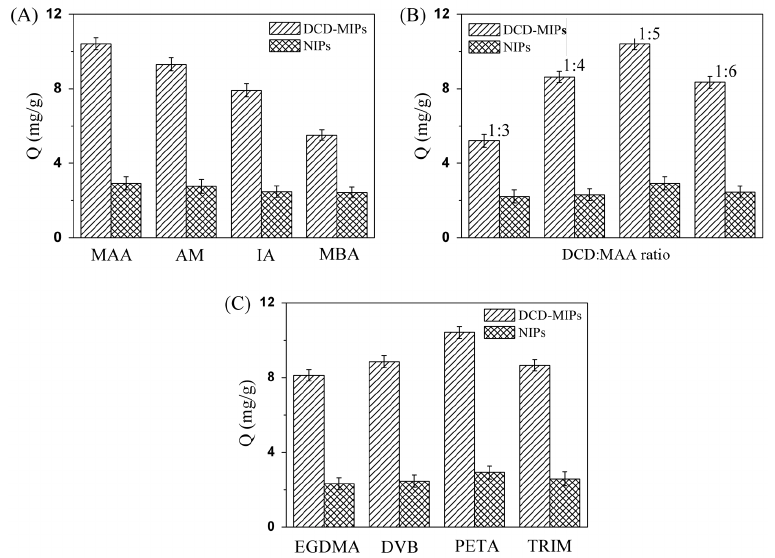
Figure 4. Adsorption capacities of MIPs and NIPs with different functional monomers ( A ); different imprinting ratios ( B ); and different cross-linking agents ( C ). Adsorption conditions: MIPs or NIPs, 20.0 mg; DCD methanol solution, 100 mg/L, 10.00 mL; 4 h.